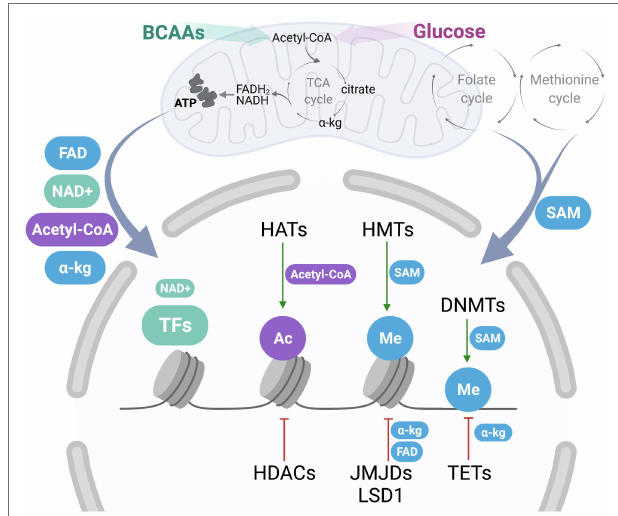
FIGURE 2 | Communication between mitochondria-derived metabolites and nuclear epigenetic regulators. One-carbon metabolism, consisting of folate and methionine cycle, generates S-adenosylmethionine (SAM), a metabolite contributing to epigenetic regulation. Oxidation of fuels, such as BCAAs and glucose, coupled to the activity of the tricarboxylic acid (TCA) cycle and the electron transport chain (ETC) produce important metabolic byproducts, including flavin adenine dinucleotide (FAD), nicotinamide adenine dinucleotide (NAD+), acetyl-coenzyme A (acetyl-CoA), and α -ketoglutarate (a-kg). Once exported out of the mitochondria, these metabolites may contribute to cytosolic signaling, or act as cofactors and donor groups to epigenetic regulators in the nucleus, including histone acetyltransferases (HATs) and deacetylases (HDACs), histone and DNA methyltransferases (HMTs and DNMTs), and demethylases that include ten-eleven translocation DNA demethylases (TETs), and histone demethylases, such as JmjC domain- containing histone demethylases (JMJDs) and histone lysine demethylase 1 (LSD1), as well as other nuclear transcription factors (TFs). HATs add acetyl groups (Ac, in purple) to histones using acetyl-CoA as a substrate, while HDACs remove these groups. HMTs utilize SAM as a donor of a methyl group (Me, in blue) to histones, while methyl groups are removed by JMJDs, which utilize a-kg, or LSD1, which couples with FAD synthesis. Similarly, DMNTs utilize SAM for DNA methylation, while a-kg is a cofactor used by TETs for DNA demethylation. Additionally, NAD+ acts as an important cofactor for nuclear TFs and other regulatory enzymes, including PARP-1 and